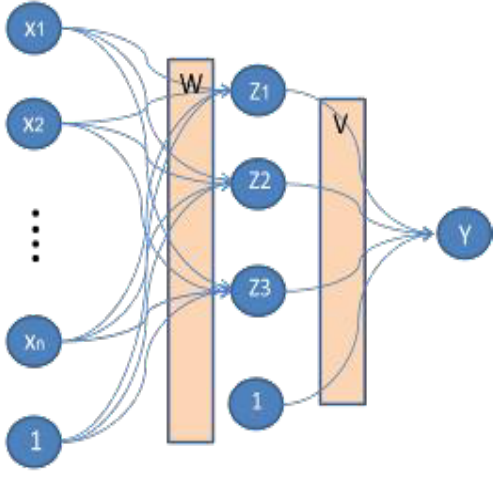
Figure 4. Back propagation neural network with one hidden layer